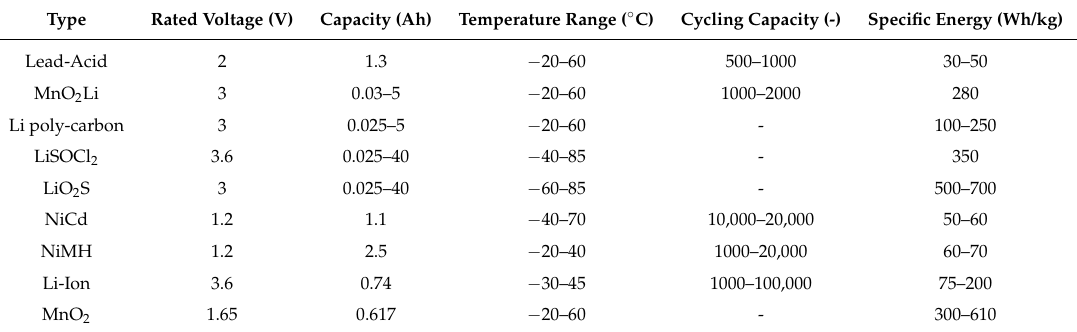
Table 2. Basic parameters of selected battery types